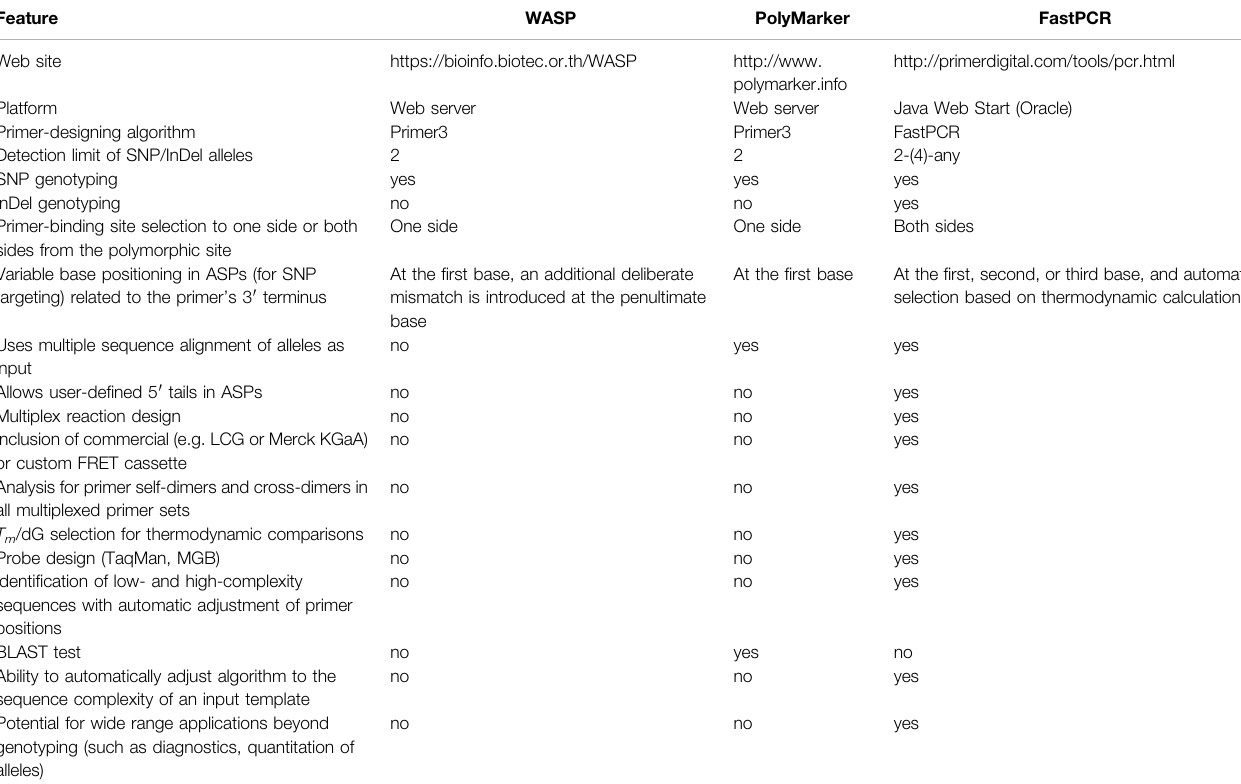
TABLE 4 | Comparison between the KASP tool (in the FastPCR suite) and other AS-PCR programs (web-based).